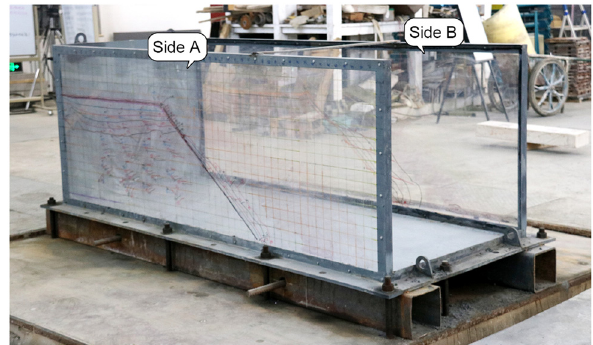
Figure 3: Test model box.